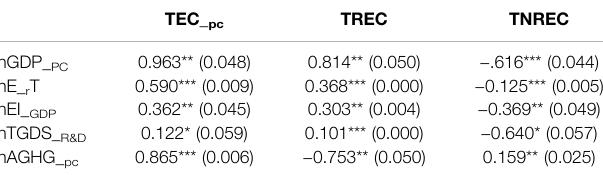
TABLE 7 | Long-run results of the dynamic panel GMM